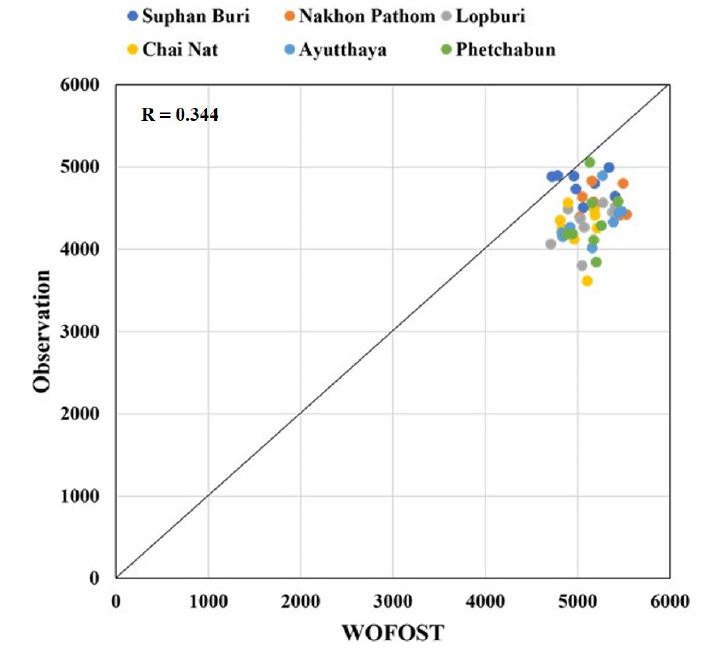
Figure 6. Correlation of the rice yield from the